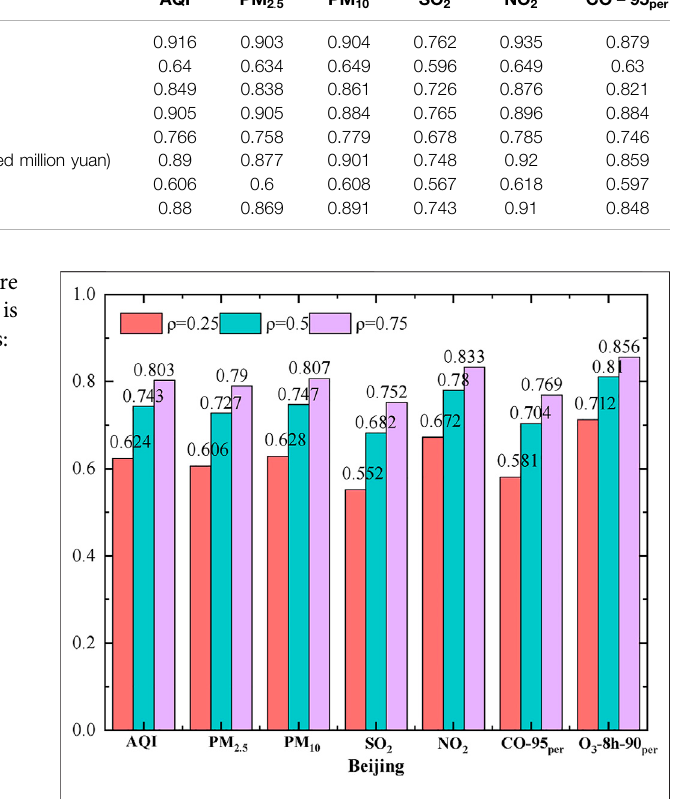
TABLE 6 | Relational analysis between socioeconomic factors and air pollutants in Zhangjiakou. Socio-economic factor